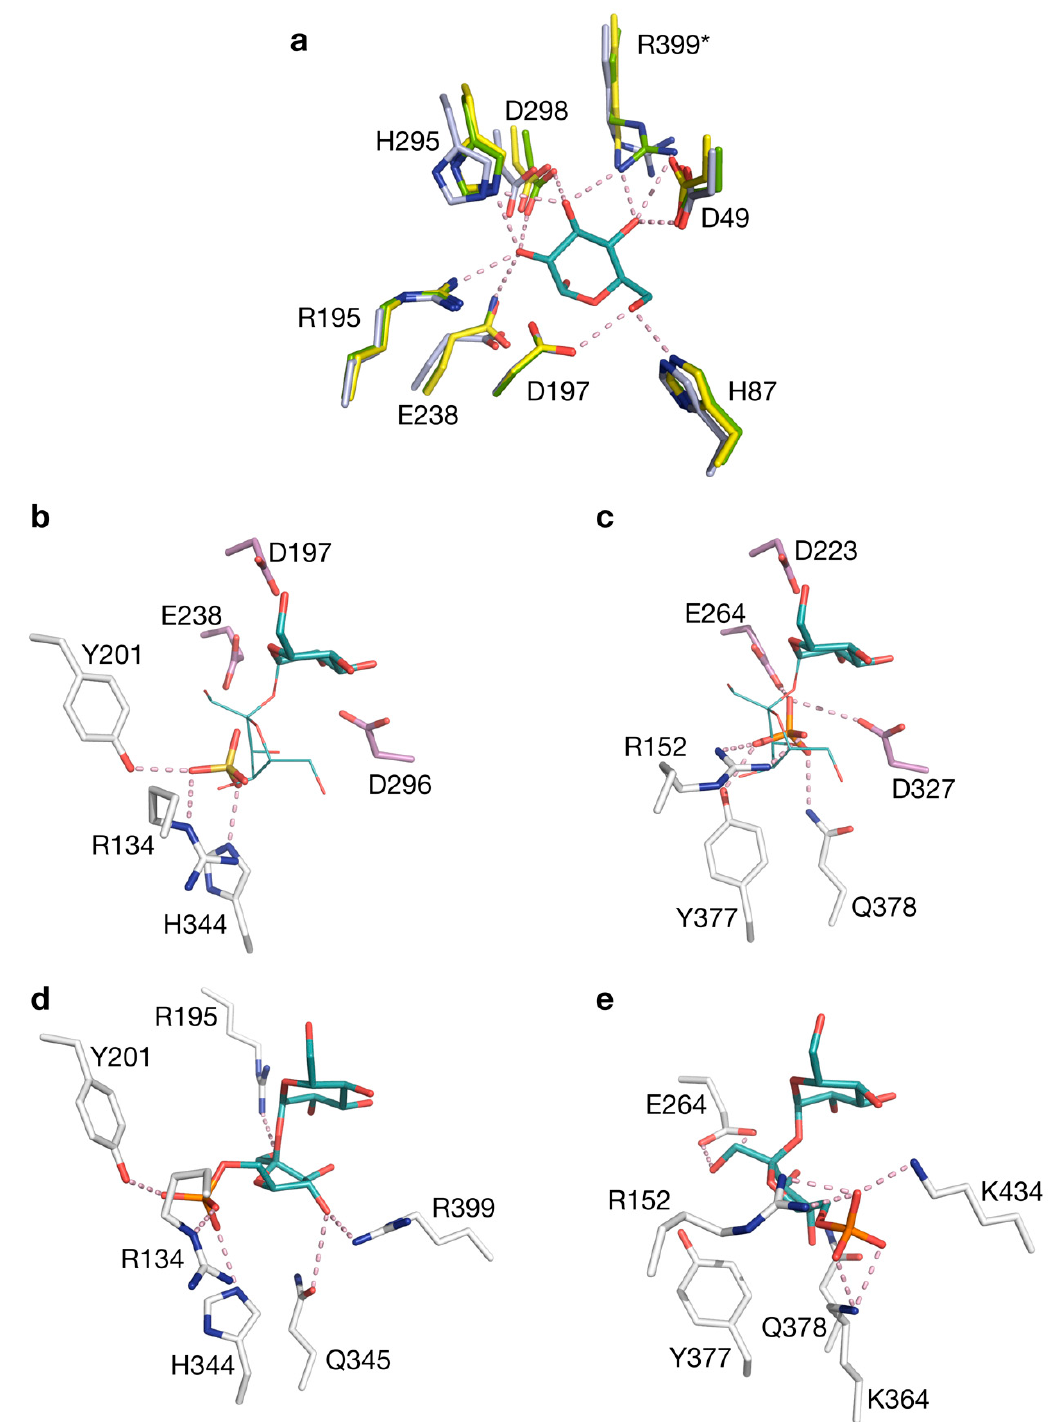
Figure 5. Active site of sucrose 6 F -phosphate phosphorylases (SPPs). ( a ) Overlay of the − 1 subsite of BaSP (green), TtSPP (blue), and IcSPP (yellow), with the glucosyl moiety of sucrose from the crystal structure of BaSP (PDB code 2GDU). Residue numbering according to TtSPP. Arg399 is substituted by Lys in IcSPP (asterisk). ( b ) Close-up view of the active site in TtSPP with a bound sulfate ion. ( c ) Close-up view of the active site in IcSPP with a bound phosphate ion. The catalytic residues are shown in purple. An overlay of sucrose from the structure of BaSP is shown for reference. Automated docking of sucrose 6 F -phosphate in ( d ) TtSPP and ( e ) IcSPP. All figures of TtSPP were made using molecule B from the asymmetric unit of the crystal structure.